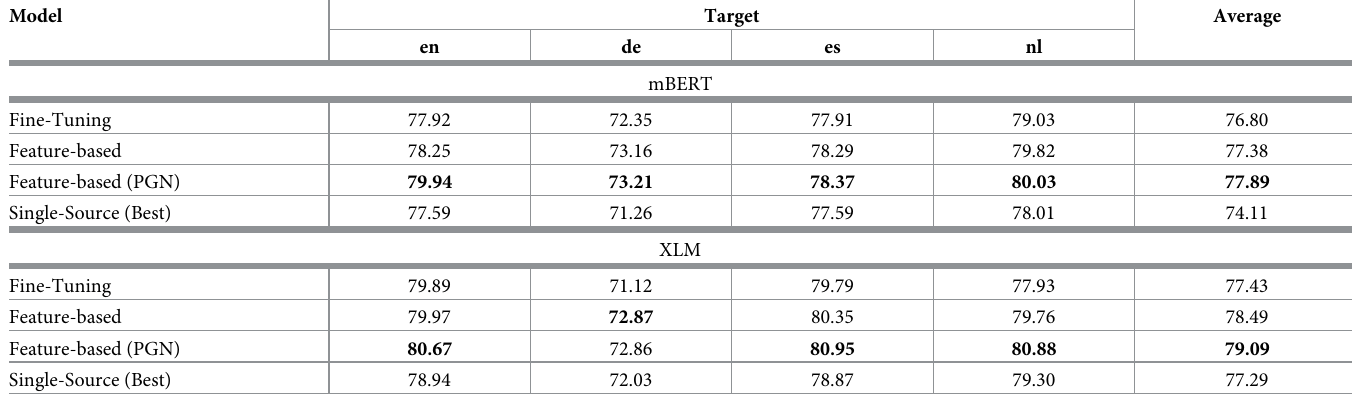
Table 3. Main results of multi-source cross-lingual NER, where all other languages except the target language itself are exploited as the source languages.